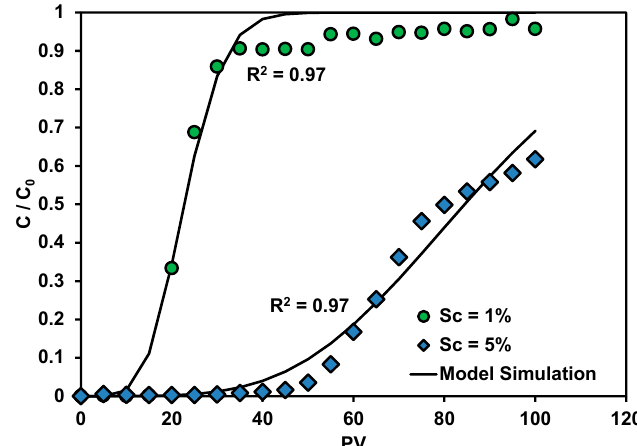
Figure 1. Observed and modeled breakthrough curves of Pb(II) under the presence of retained kaolinite colloidal particles at 1% and 5%. Back-calculated ω 2 and k c are also presented with R 2 values. PV: pore volume.